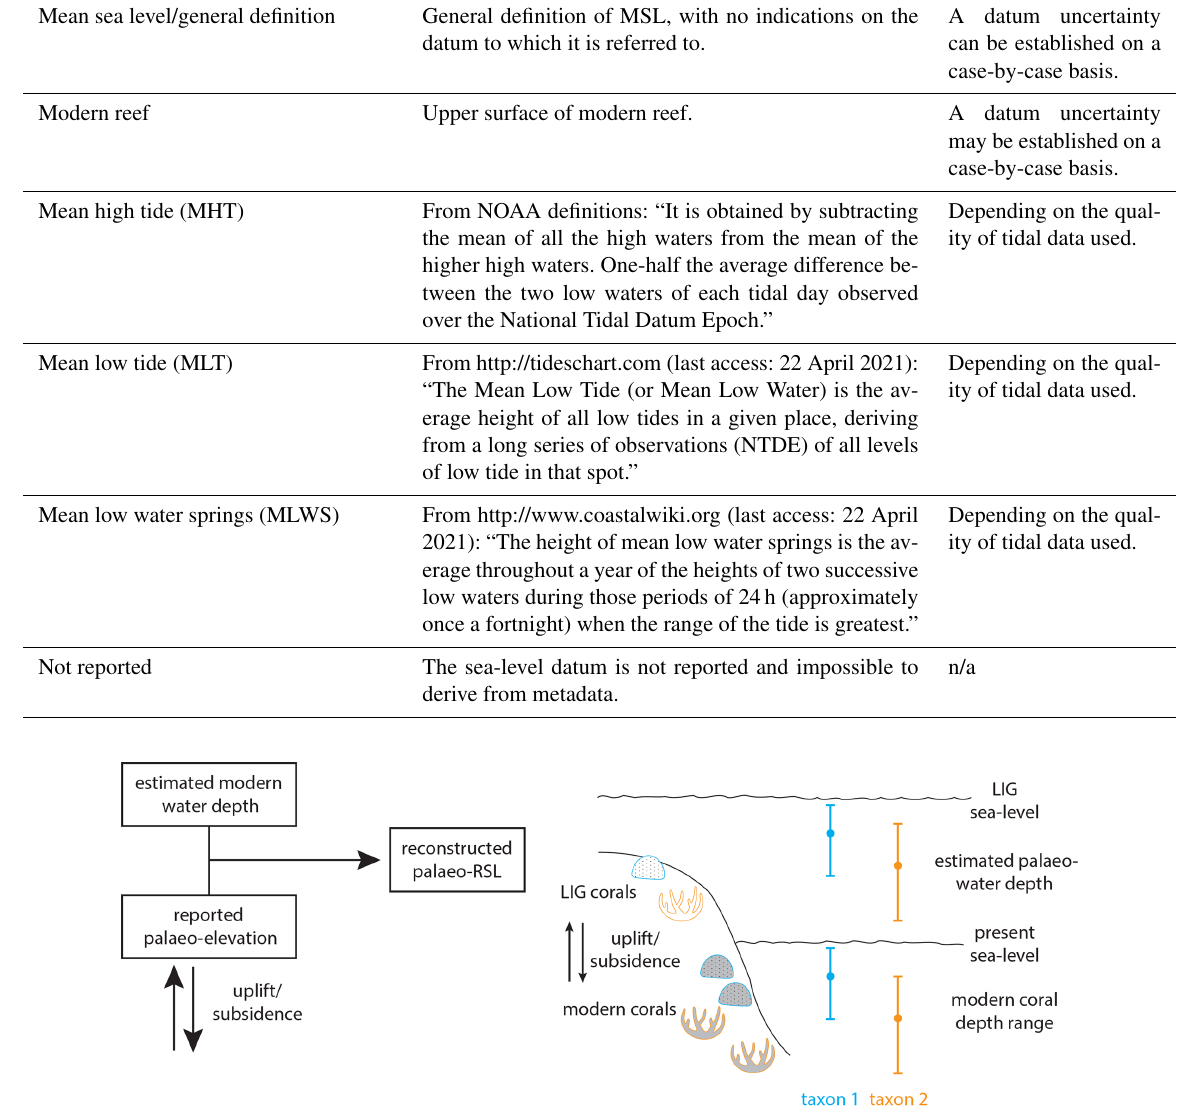
Figure 14. Reconstruction of palaeo-relative sea level (RSL) based on reported palaeo-elevations of last interglacial (LIG) corals and esti- mated palaeo-water-depth intervals of their modern counterparts. The range bars indicate maximum, median and minimum depths. Modern corals are shown in grey and LIG corals in